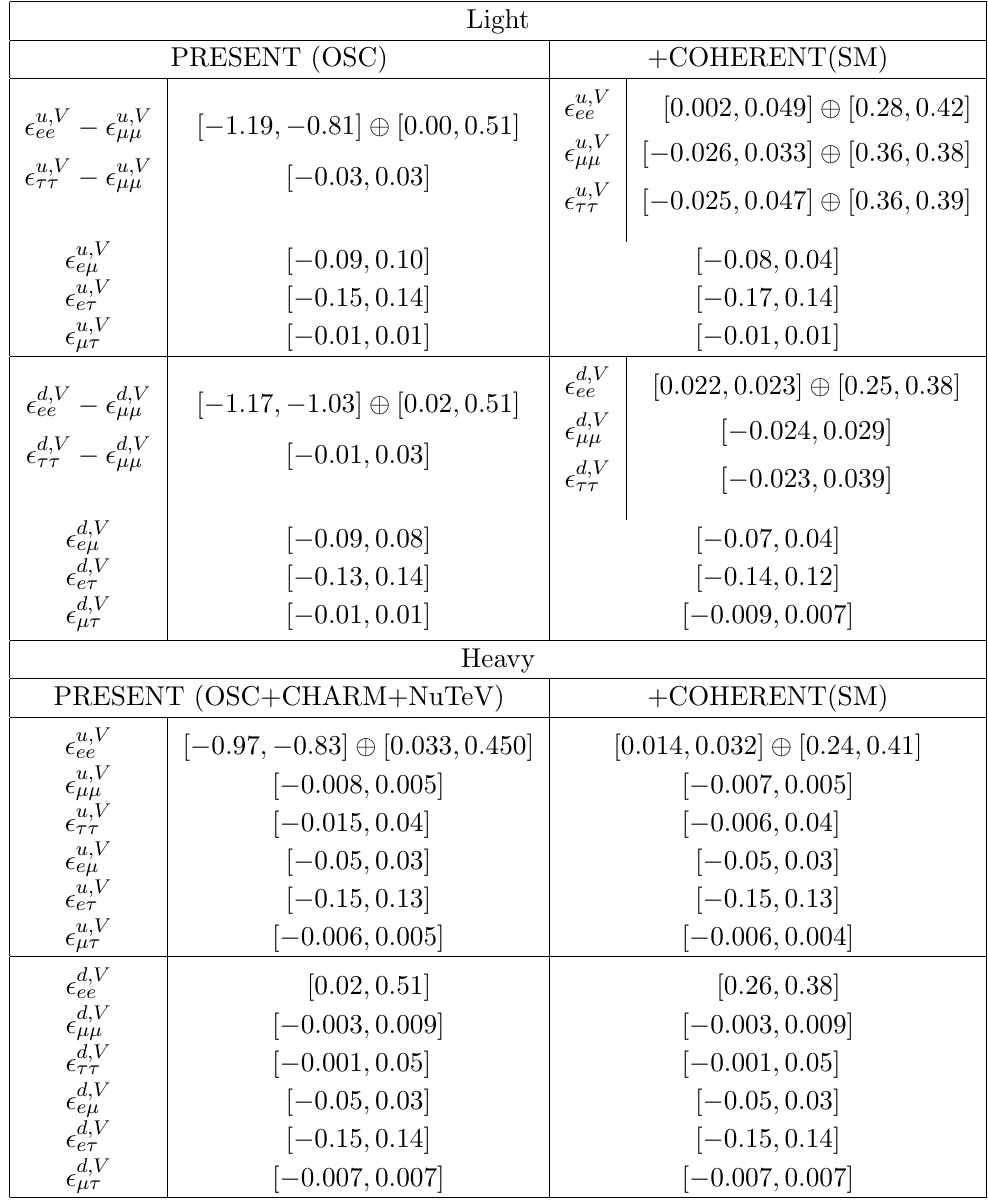
Table 1 . 90% and allowed ranges for the NSI parameters (cid:15) f di(cid:11)erent combined analyses. The upper (lower) part of the table corresponds to models of NSI’s generated by light (heavy) mediators. The results in each panel are obtained after marginalizing over oscillation and the other NSI parameters. See text for details.